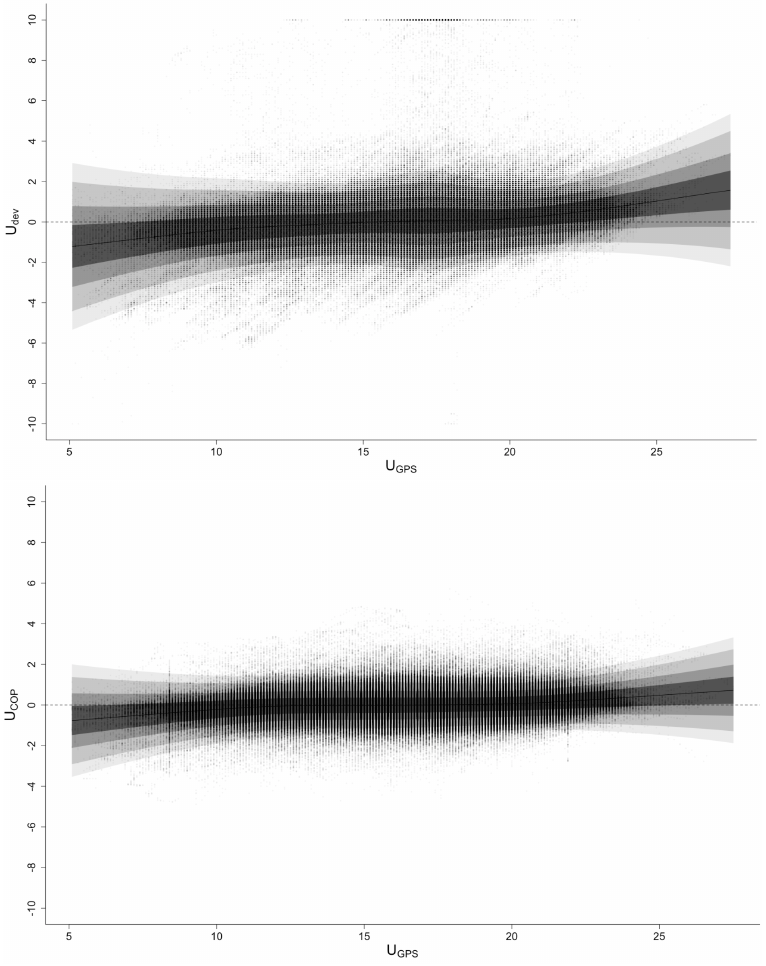
Figure 22. Centile curves using GAMLSS of U dev and U COP over U GPS as explanatory variable for the main